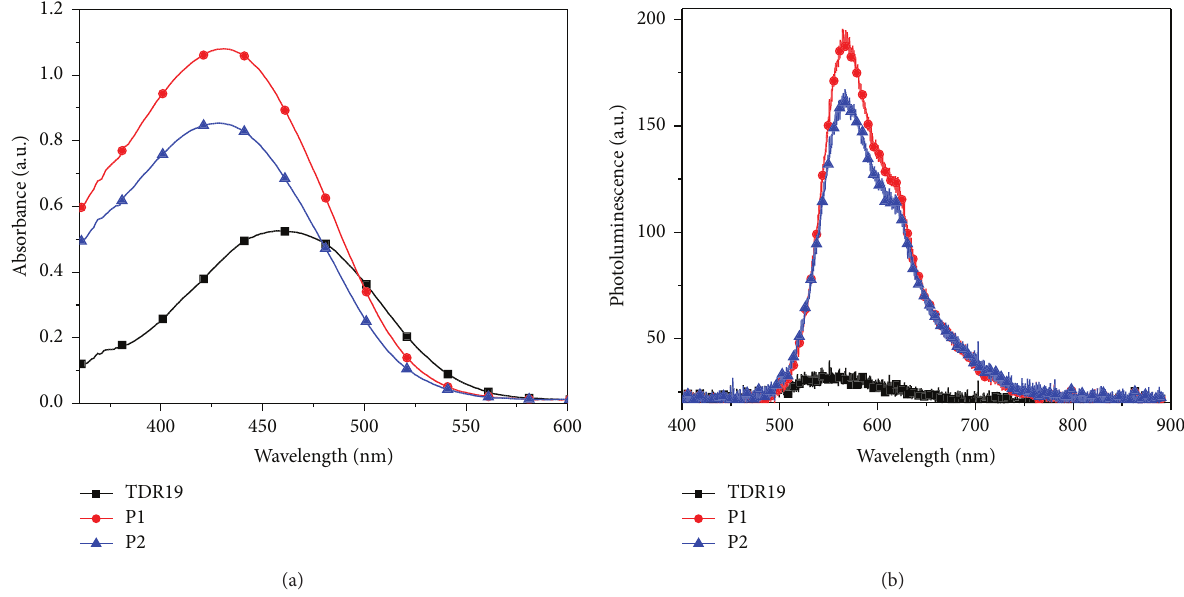
Figure 2: (a) Absorption and (b) emission spectra of solutions (0.1mg/mL) in THF of monomer TDR19 and copolymers P1 and P2.